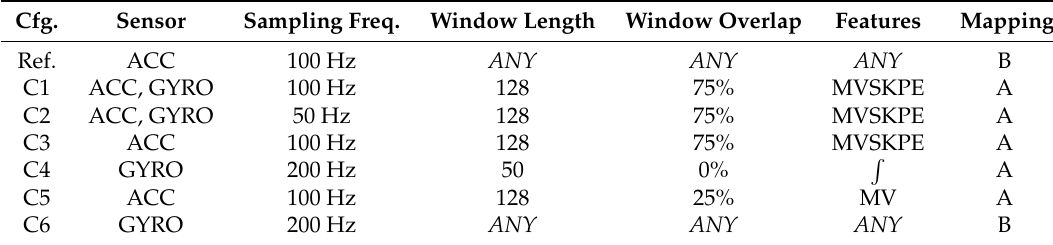
Table 1. Sensor settings, sampling frequencies, sliding window parameters, feature sets, and mappings of all configurations. Cfg. Sensor Sampling Freq. Window Length Window Overlap Features Mapping